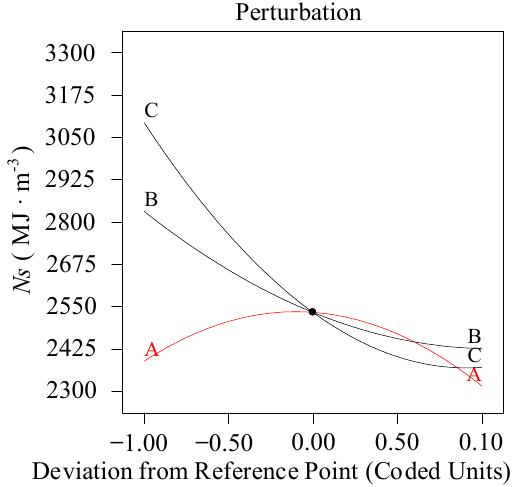
Figure 5. Comparison chart between predicted value and measured value (N s ).